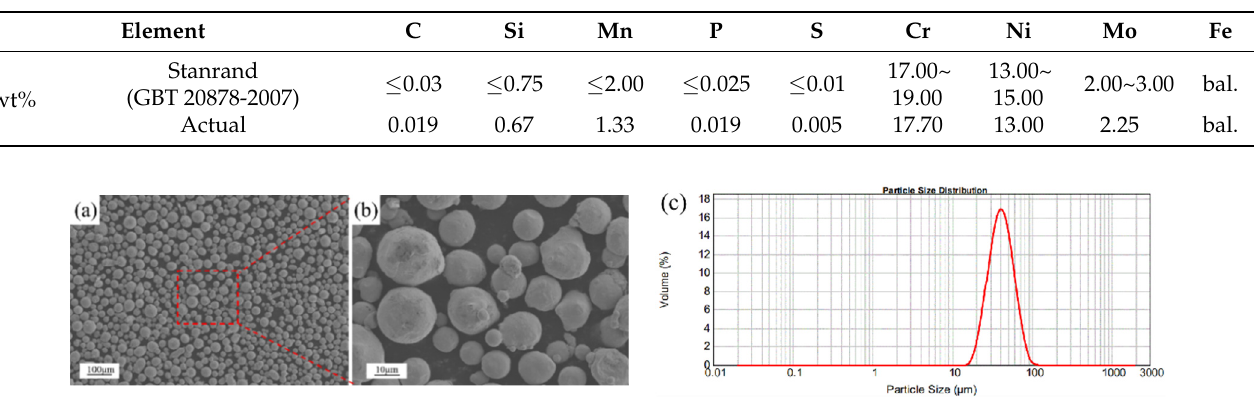
Table 1. Chemical composition of as-received 316 L stainless steel powder (weight percent).